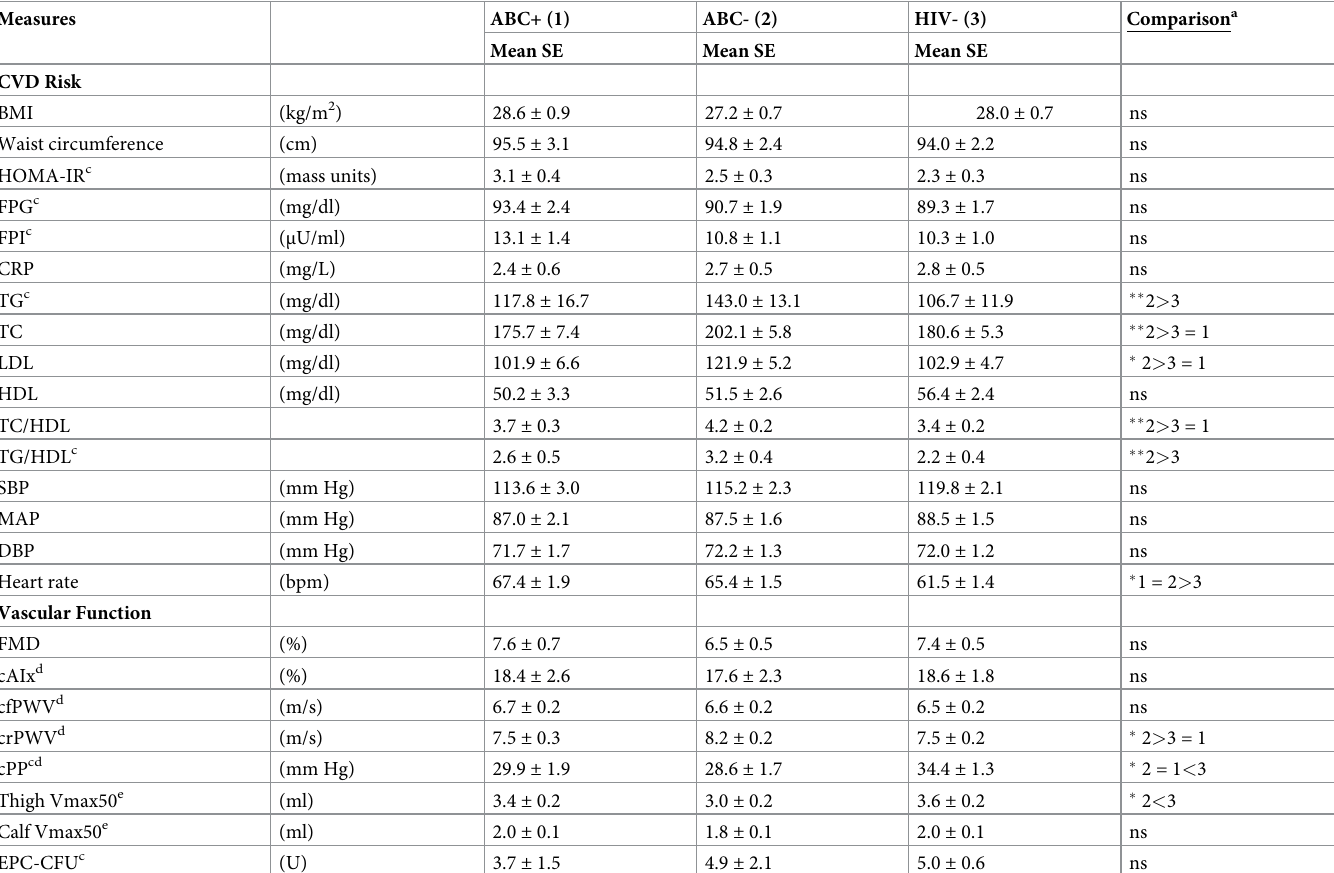
Table 5. Subclinical cardiometabolic measures comparing study groups when controlling for demographic variables (sex, age, education) and prescribed medica- tions (antihypertensive, statin-fibrate, antipsychotic, thyroid).